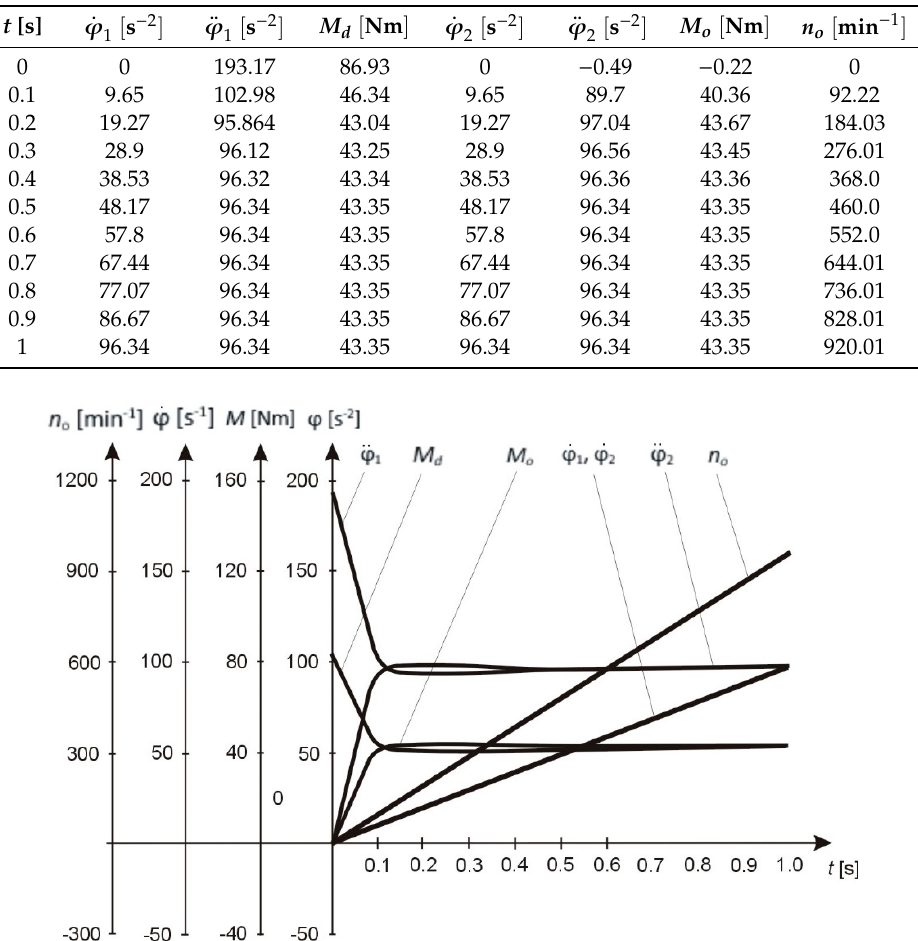
Figure 6. The nature of changes in the parameters of the technological process.